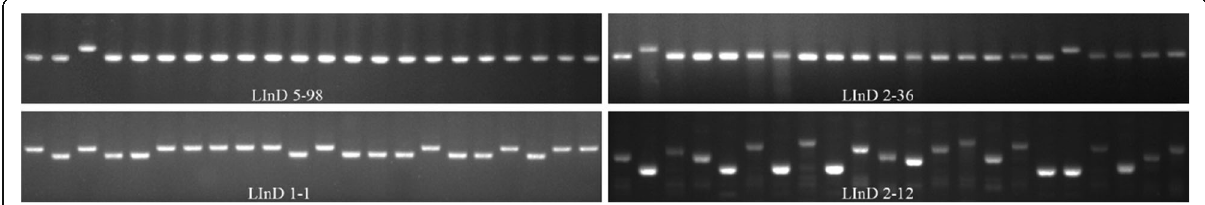
Fig. 2 The genotype of four representative LInDel markers of LInD5 – 98, LInD2 – 36, LInD1 – 1 and LInD2 – 77. The samples from left to right are as follows: Zhonghua11, Zhenhan97, Minghui63, Xizang2, N22, Nipponbare, 9311, 02428, Teqing, Taichong65, Chun7, Haobuka, Wuyujing3, Gangye, H360, Zidao, Heimizhan, Changguizidao, Xiushui133, AUS449, Mitak and